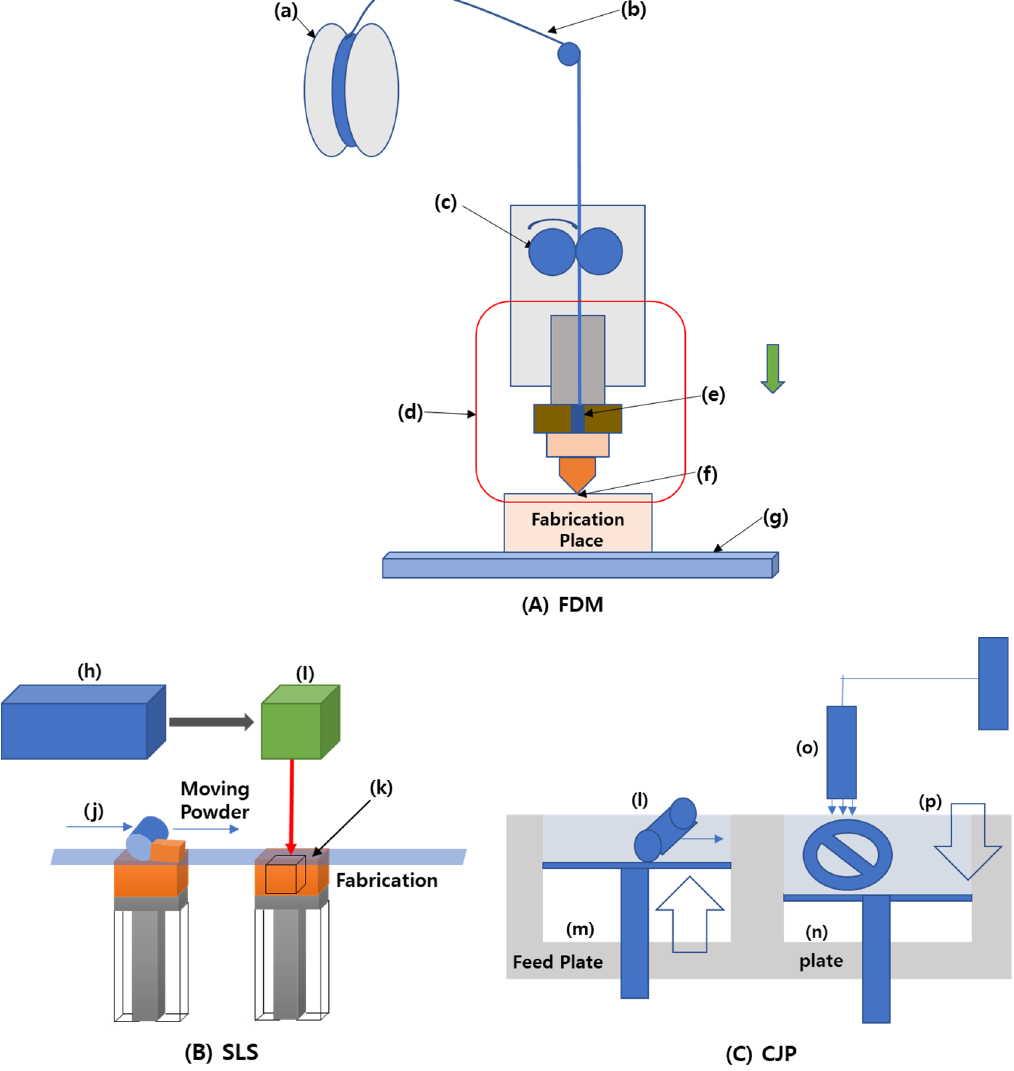
Figure 1. Scheme of main 3D printing technologies. ( A ) Fused Deposition Modeling (FDM): (a) Coil reel; (b) Plastic filament; (c) Driving motor; (d) Extruder; (e) Molten paste chamber; (f) Nozzle tip; (g) FDM printer bed, ( B ) Selective laser sintering (SLS): (h) Laser; (i) Scanner system; (j) Roller; (k) Power bed, and ( C ) Color-jet printing: (l) Roller; (m) Powder; (n) Build; (o) Color binder header; (p) Modeling part.